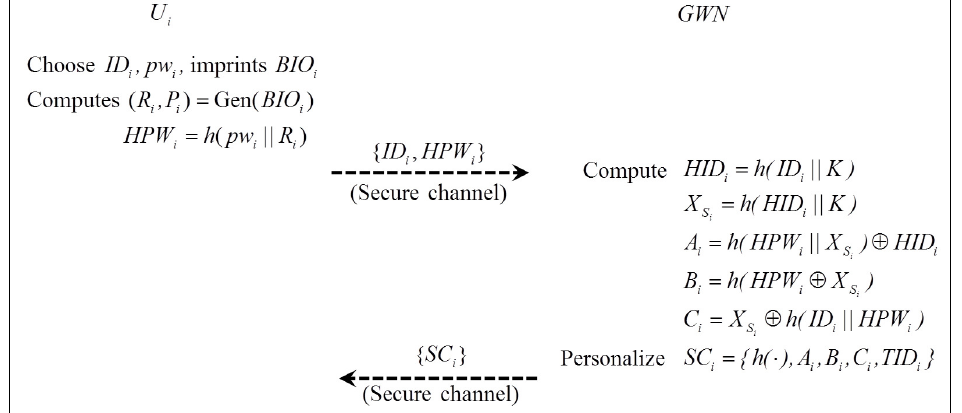
Figure 1. Registration